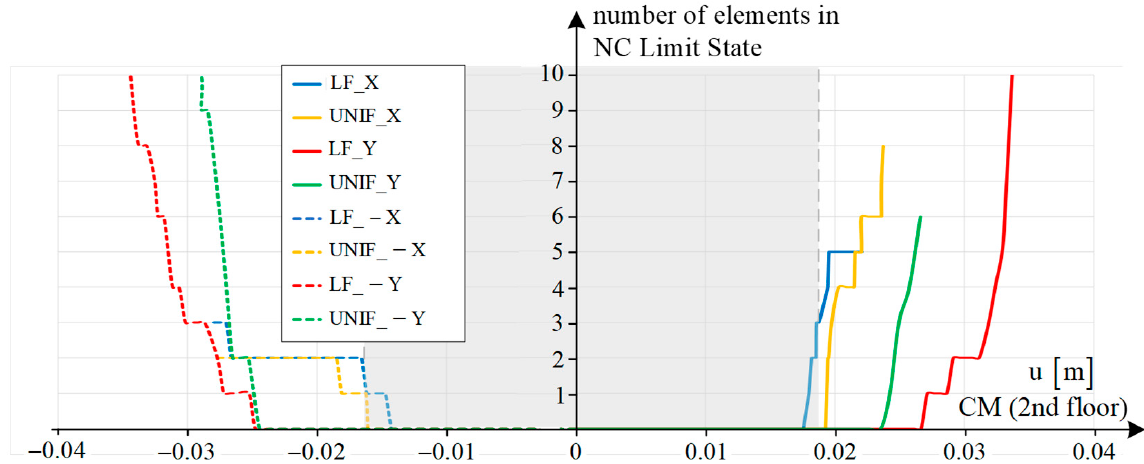
Figure 17. Cumulative number of elements in NC limit state.